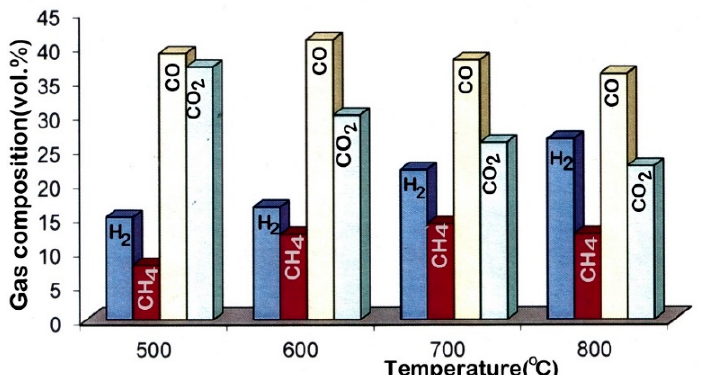
Figure 5. Temperature influence on gas composition (slow pyrolysis; moisture content, 48.15 wt.%; striping gas flow rate, 40 L/h).